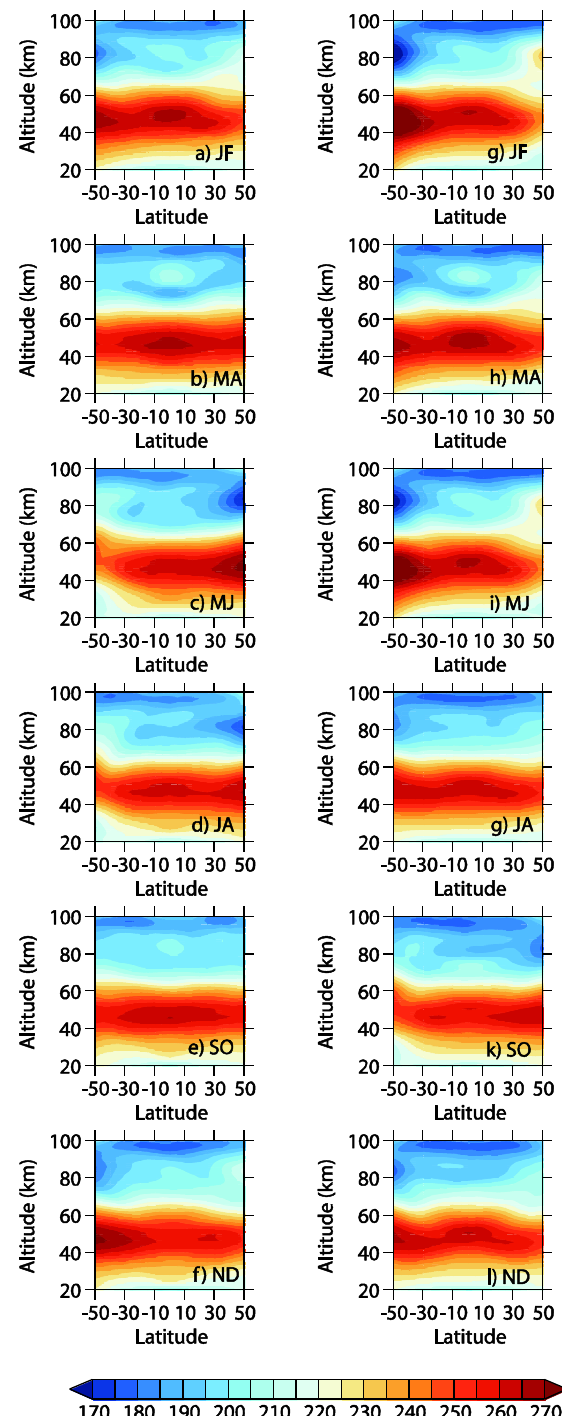
Fig. 6. The real (left column) and reconstructed (right column) tem- perature between 20 and 100km for JF, MA, MJ, JA, SO, ND in